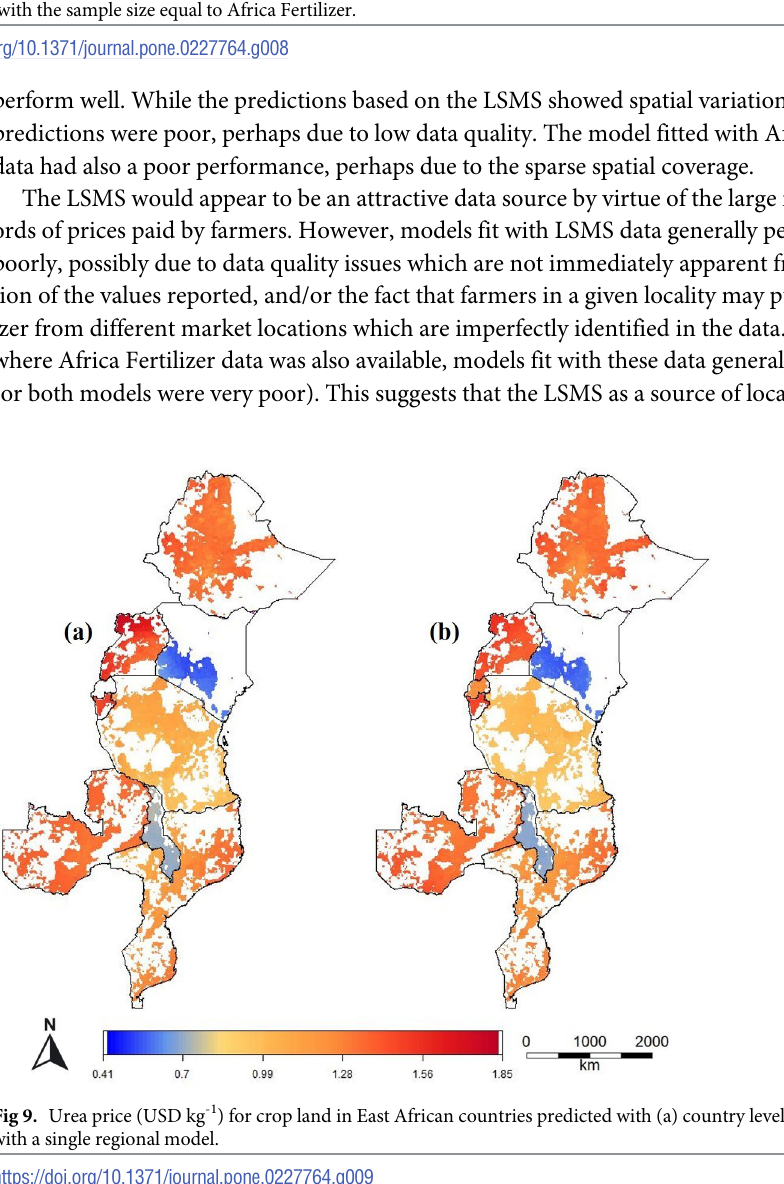
Fig 8. Predicted relative urea price (local price divided by the observed median national price) for areas with crop land in (a) Tanzania using Africa Fertilizer data; (b) Tanzania using LSMS data; (c) Tanzania using Africa Fertilizer data and a sub-sample of LSMS data with the sample size equal to Africa Fertilizer.